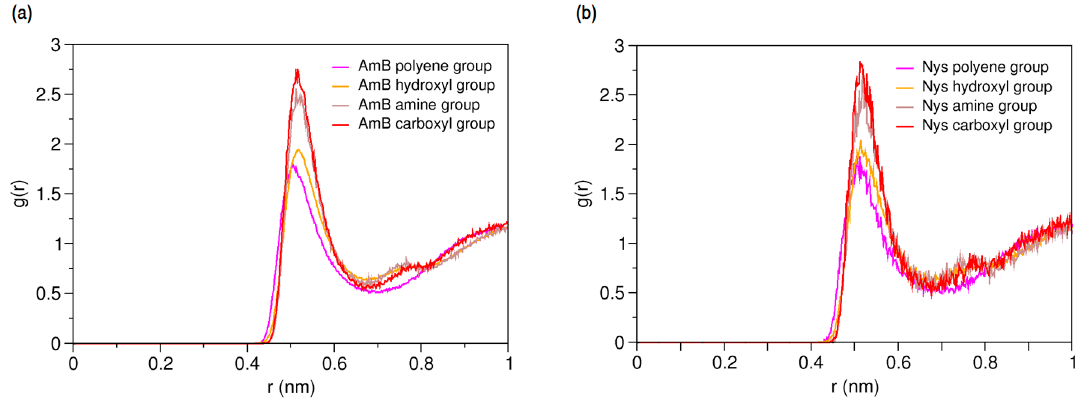
Figure 3. Average radial pair distribution functions for various moieties of ( a ) a single Amphotericin B (AmB) molecule; and ( b ) a single Nystatin (Nys) molecule against water particles. B (AmB) molecule; and ( b ) a single Nystatin (Nys) molecule against water